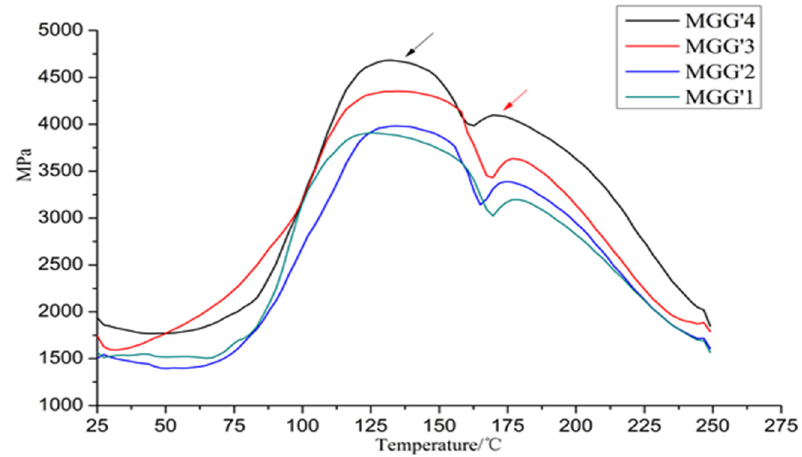
Figure 1. Thermomechanical analysis (TMA) curves showing the Modulus of Elasticity (MOE) as a function of temperature for the hardening of the MGG’ adhesives from Tables 1 and 2.